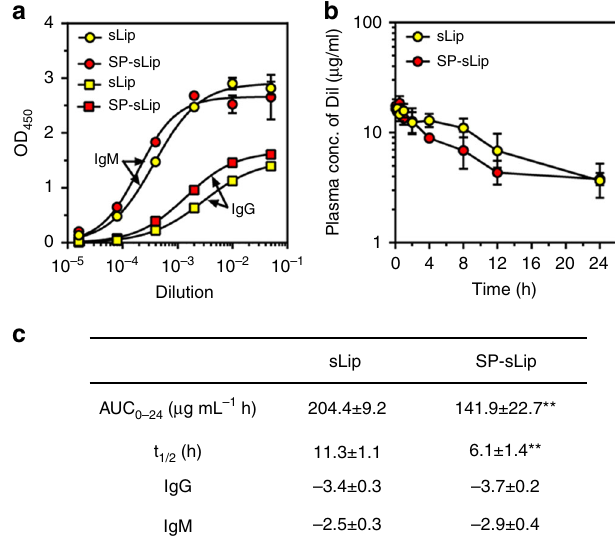
Fig. 7 Evaluation of immunocompatibility of SP-sLip. a Immune response caused by sLip or SP-sLip in C57BL/6 mice. Absorbance in the ELISA plate versus serum dilution and antibody titer reported as log (EC50). mPEG2000-DSPE and SP-PEG3400-DSPE were used as antigens for sLip and SP-sLip, respectively. Data are means± SD ( n = 5). b Pharmacokinetic pro fi le of DiI-labeled sLip and SP-sLip in SD rats over 24 h after intravenous injection. Data are means ± SD ( n = 4) c PK parameters are calculated by DAS 2.0, and titration of IgG and IgM was calculated using GraphPad Prism 6.0. ** p < 0.01 by student ’ s t -test